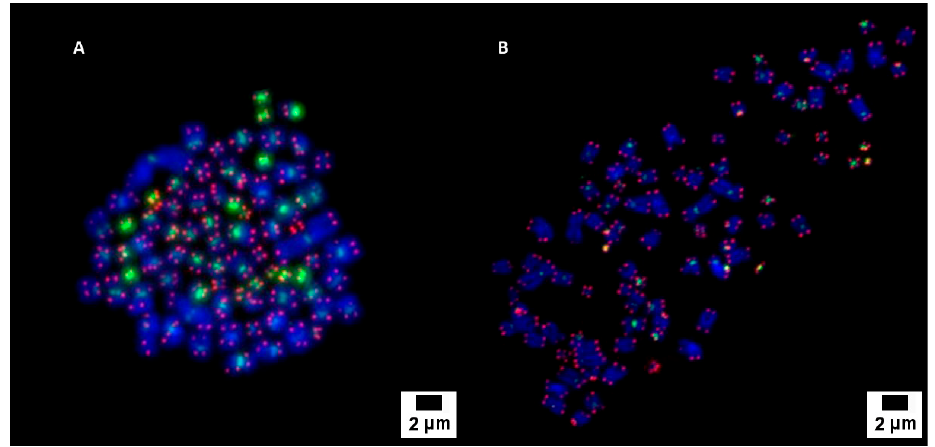
Figure 2. Pancentromeric–pantelomeric fluorescence in situ hybridization-stained metaphases of Caco2 ( A ) and SKBR3 ( B ) cells. Green signals correspond to centromeres, labeled with FITC; and red signals to telomeres, labeled with Cy3.